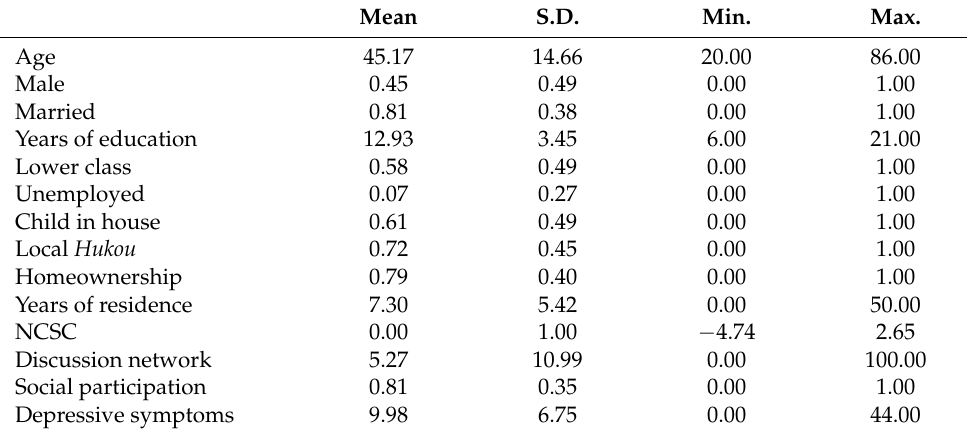
Table 2. Sample profile (N =